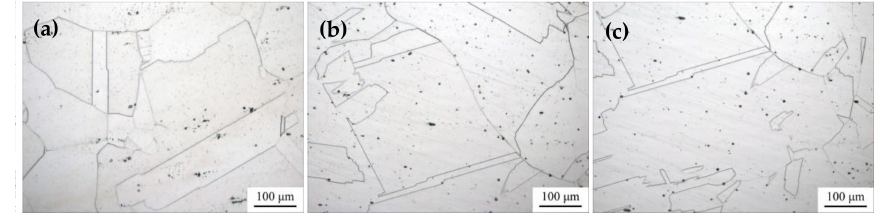
Figure 7. OM micrograph of welding thermal simulation specimens with additional loading after heat treatment: ( a ) 450 ◦ C; ( b ) 550 ◦ C; ( c ) 650 ◦